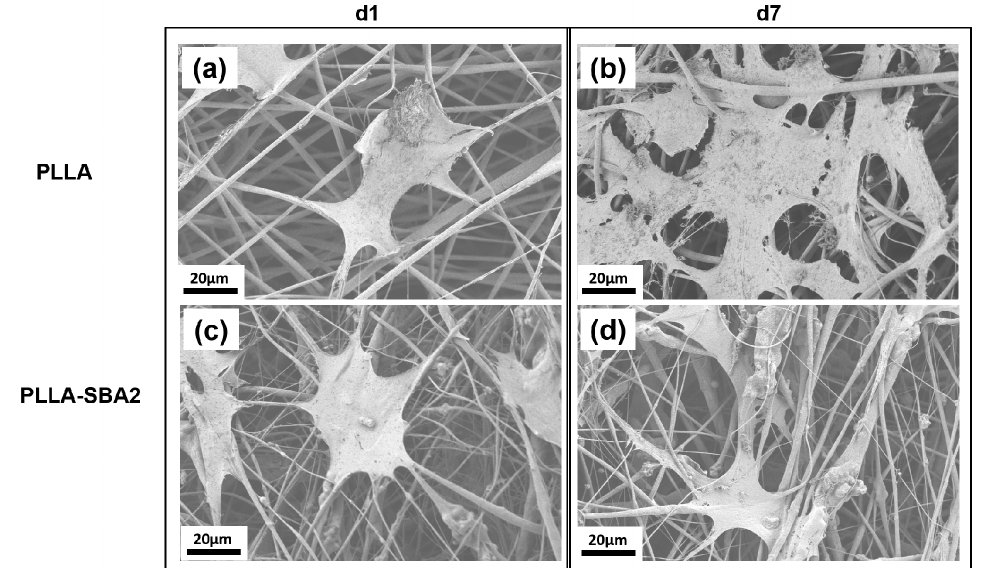
Figure 8. SEM micrographs of dehydrated ST2 cells, cultured on neat ( a , b ) and composite ( c , d ) fibres for 1 ( a , c ) and 7 ( b , d ) days. Scale bar: 20 µm.